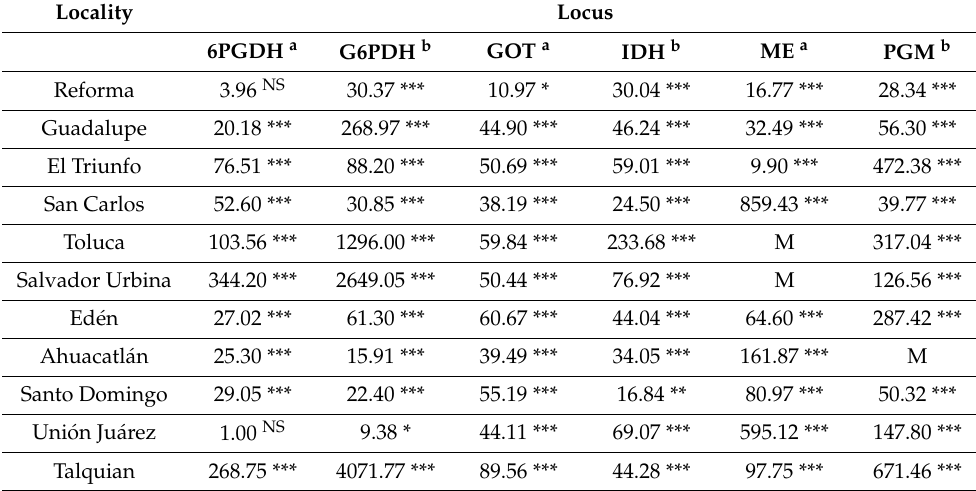
Table 4. Results of the χ 2 analyses to test for random mating of Anastrepha ludens collected from 11 localities in the Soconusco region, in Chiapas, Mexico: a , loci with only two alleles; b , loci with three alleles; NS,notsignificant; M,monomorphiclocus; p * < 0.05, **; < 0.01, *** < 0.001. Detailsoftheresultsof this analysis are in Table S2. (Supplement 02) ME, malate dehydrogenase; IDH, isocitrate